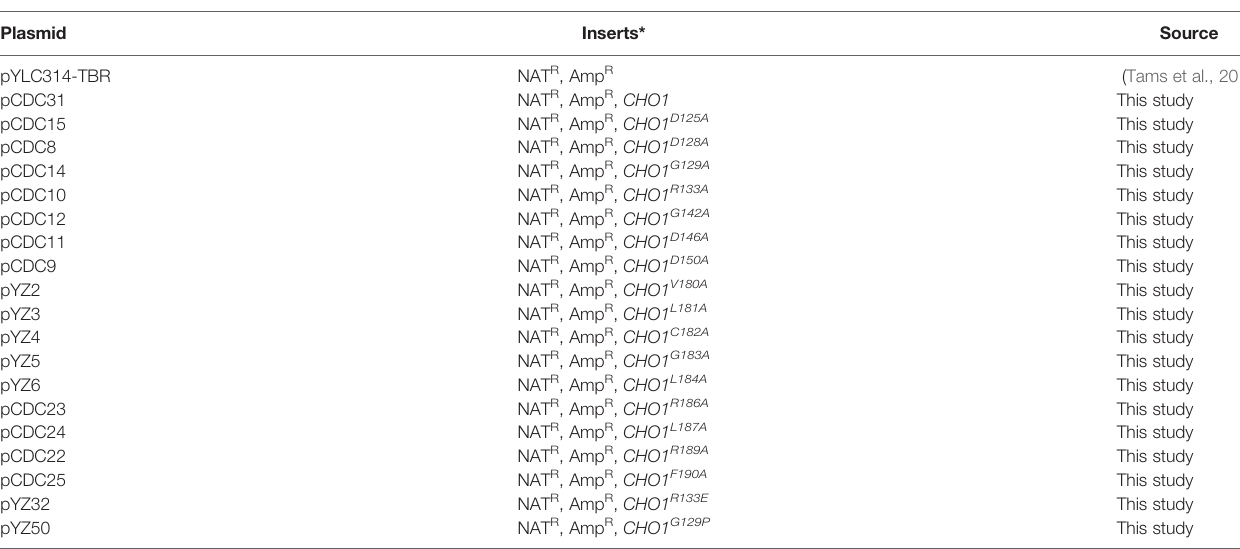
TABLE 3 | Plasmids used in this study.